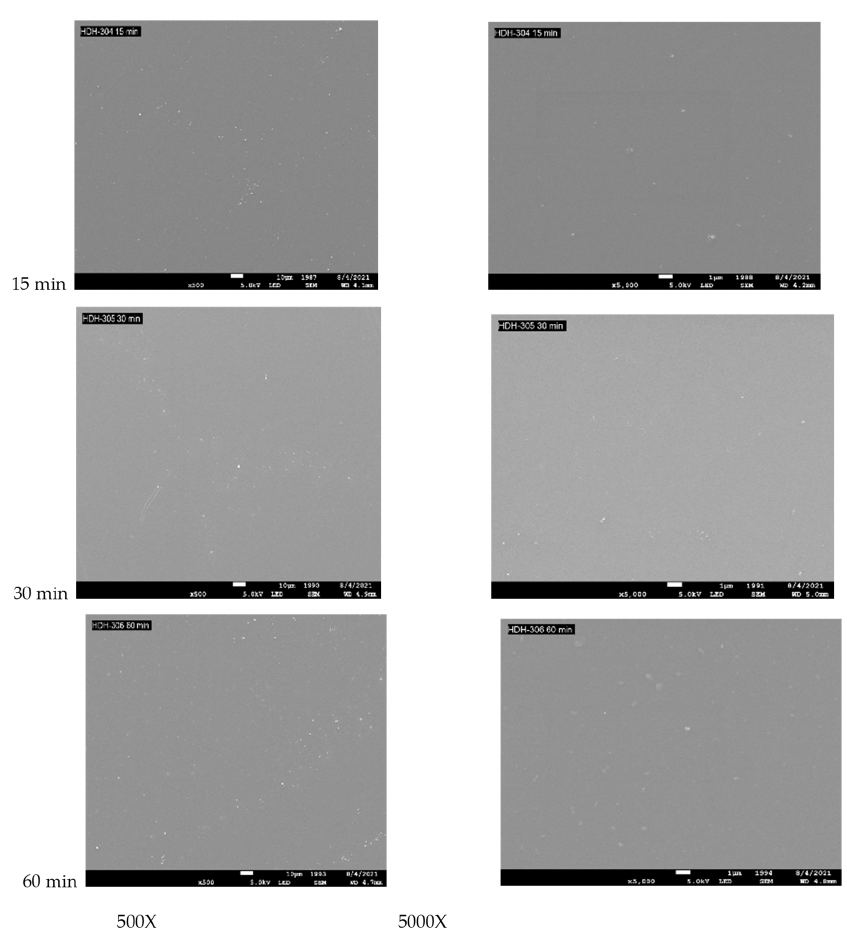
Figure 8. SEM surface topographic images at 500× and 5000× magnification after 15, 30, and 60 min treatment with VUV photo-oxidation.